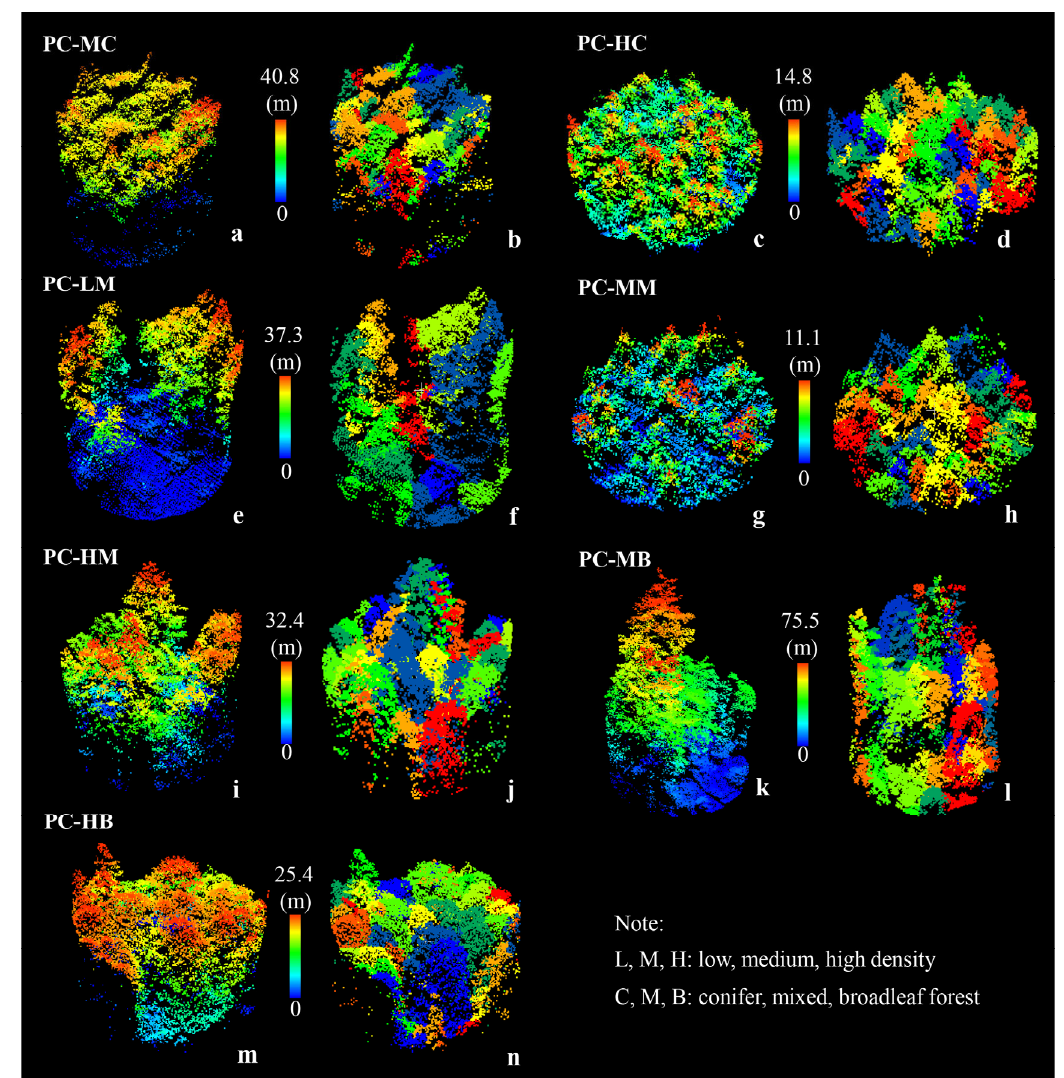
Figure 7. Height ‐ normalized airborne ‐ laser ‐ scanning data (insets a , c , e , g , i , k , m ) and corresponding tree ‐ segmentation results (insets b , d , f , h , j , l , n ) of seven types of forest plot. Different colors represented different trees in the tree ‐ segmentation results .